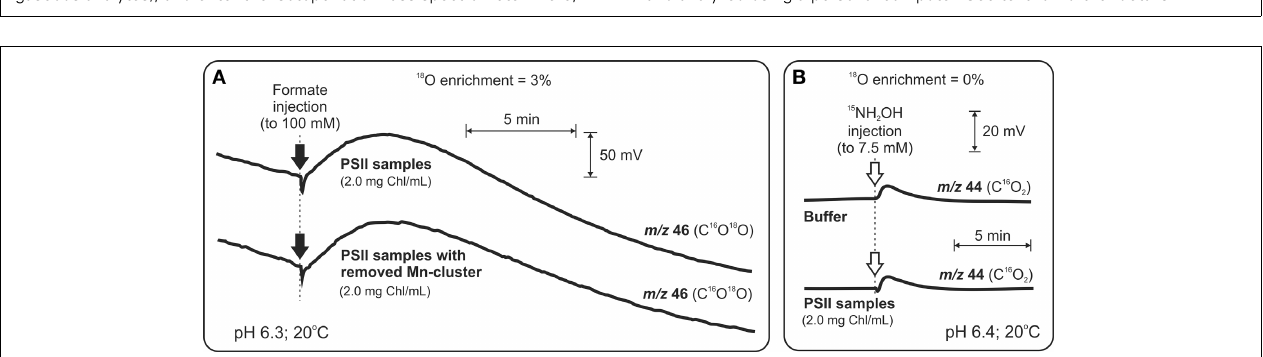
gaseous analytes are first ionized in the ion source by electron impact, and are then separated according to their m/z ratios by a magnetic field in the sector analyzer that allows simultaneous online detection by individual collector cups (e.g., a 7-cup Faraday detector array). MS signals are monitored and analyzed using a personal computer. See text for further details.